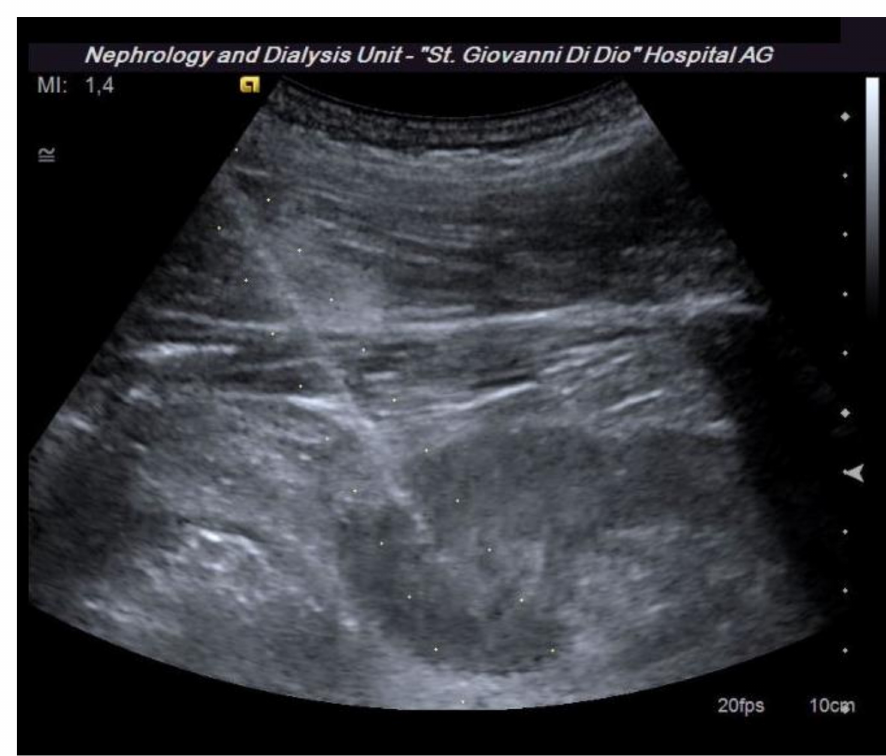
Figure 5. US highlights the trajectory of the needle that crosses the capsule with the tip in the internal region of the cortex. This image shows the needle after the activation of the trigger mechanism. The operator must verify that the needle does not reach the region of the renal pelvis, considering both the trajectory and the maximum possible excursion of the tip after the activation of the trigger